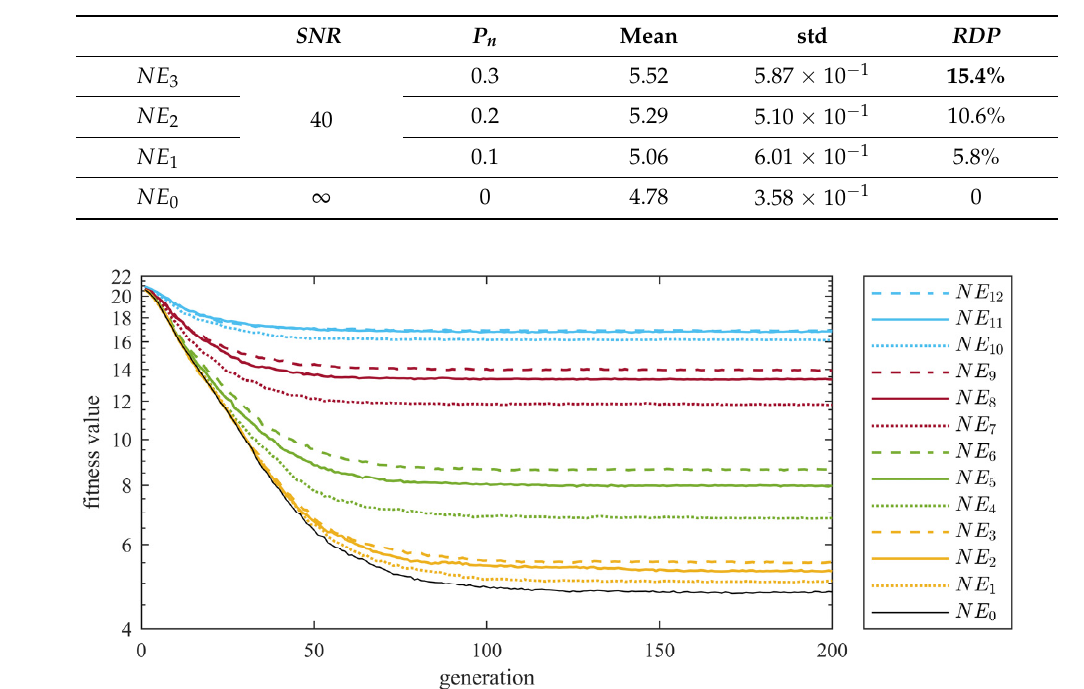
Figure 3. Convergence curves of DDEA-SE on 30-dimensional Ackley problem with different noise levels.